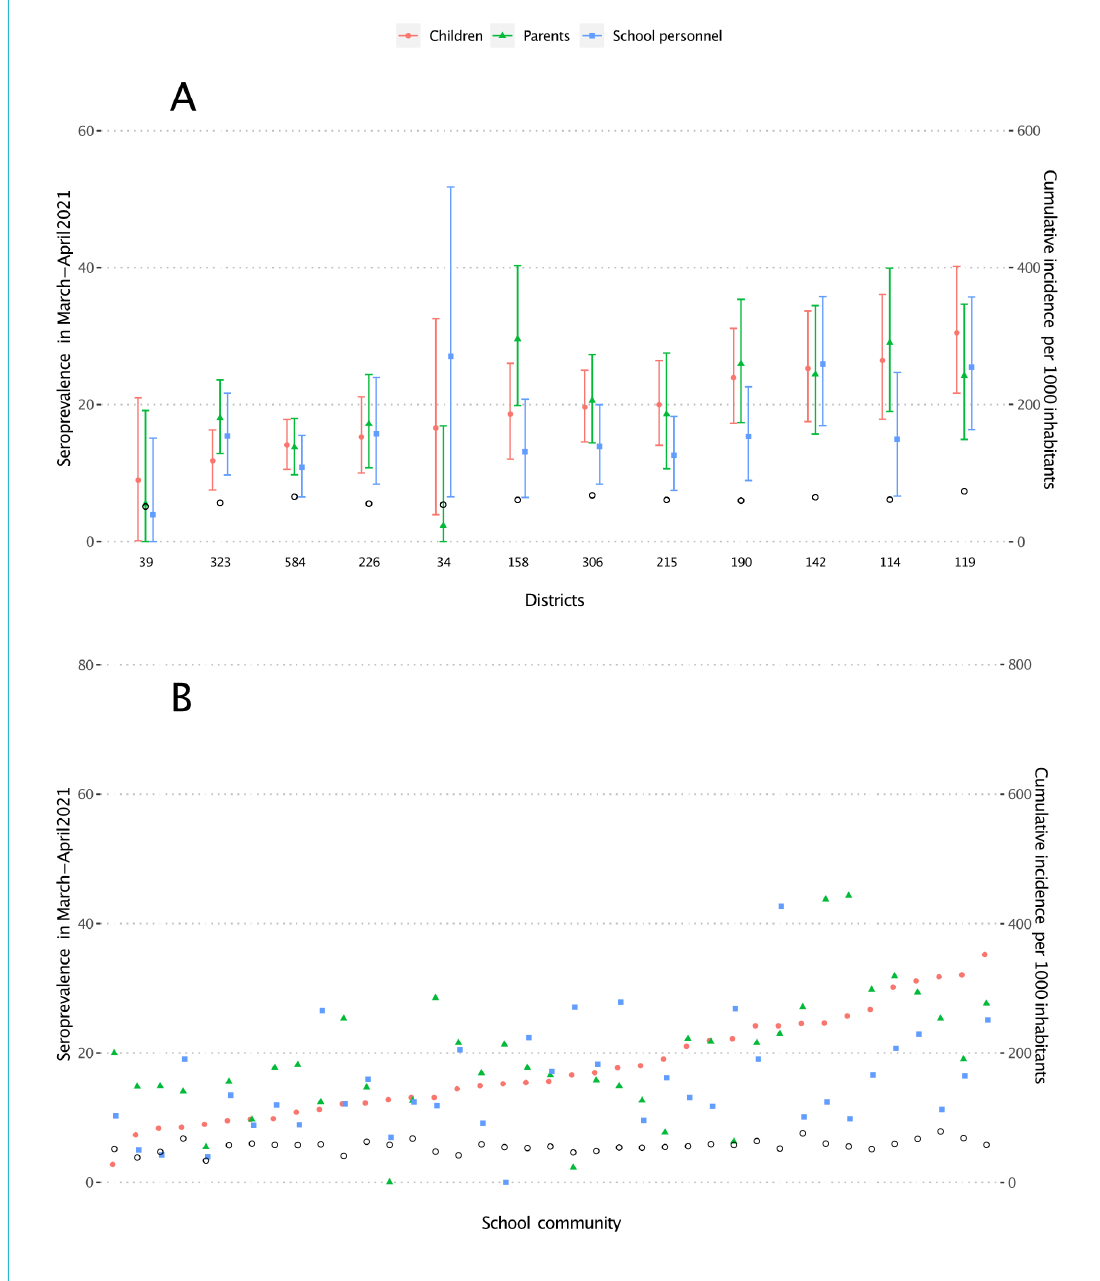
Figure S1: Seroprevalence in children, parents and school personnel and cumulative incidence of the population in the canton of Zurich, Switzerland, in March-April 2021. A – within the cantonal districts, B – within school communities Empty black circles represent cumulative in-